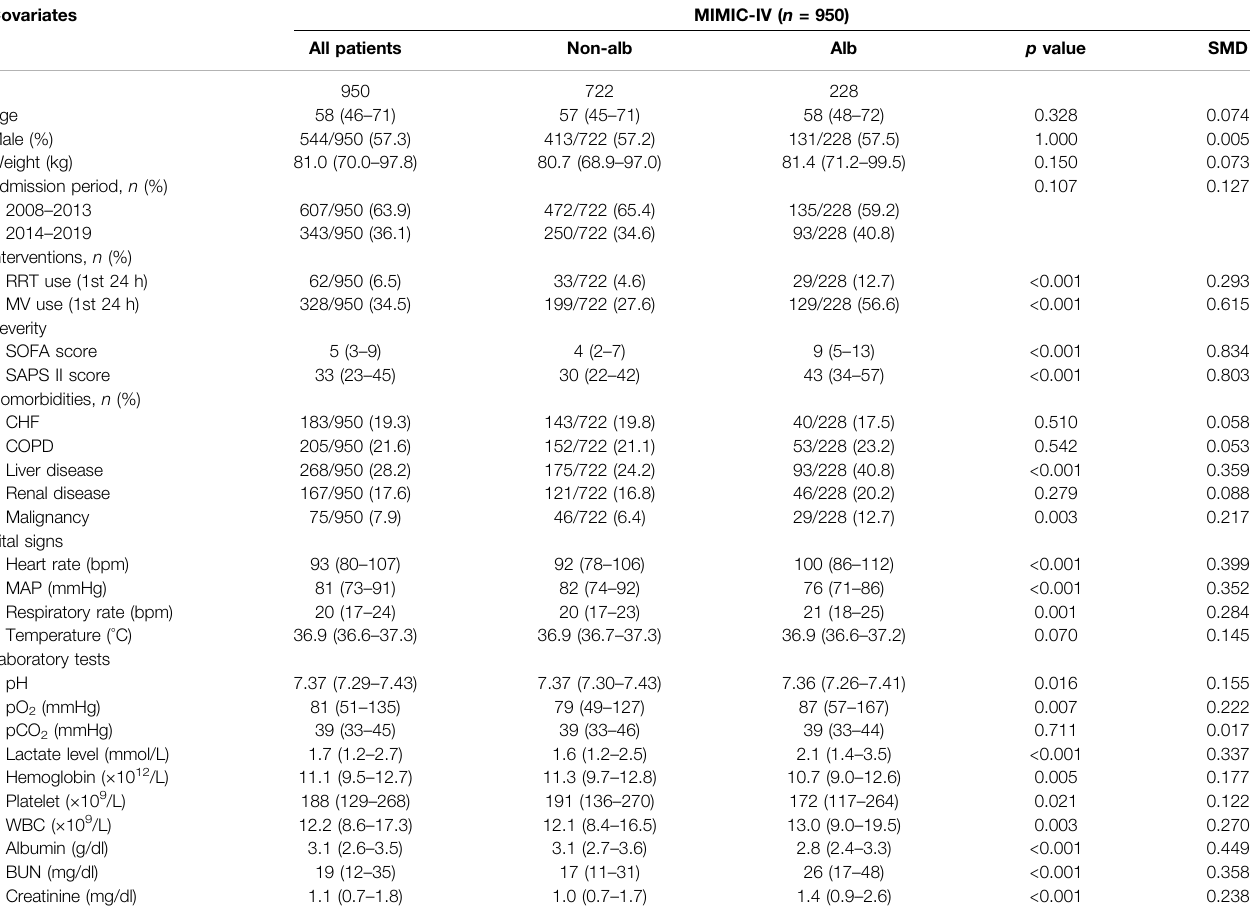
TABLE 1 | Baseline characteristics of the included patients from the MIMIC-IV database. Covariates MIMIC-IV ( n =